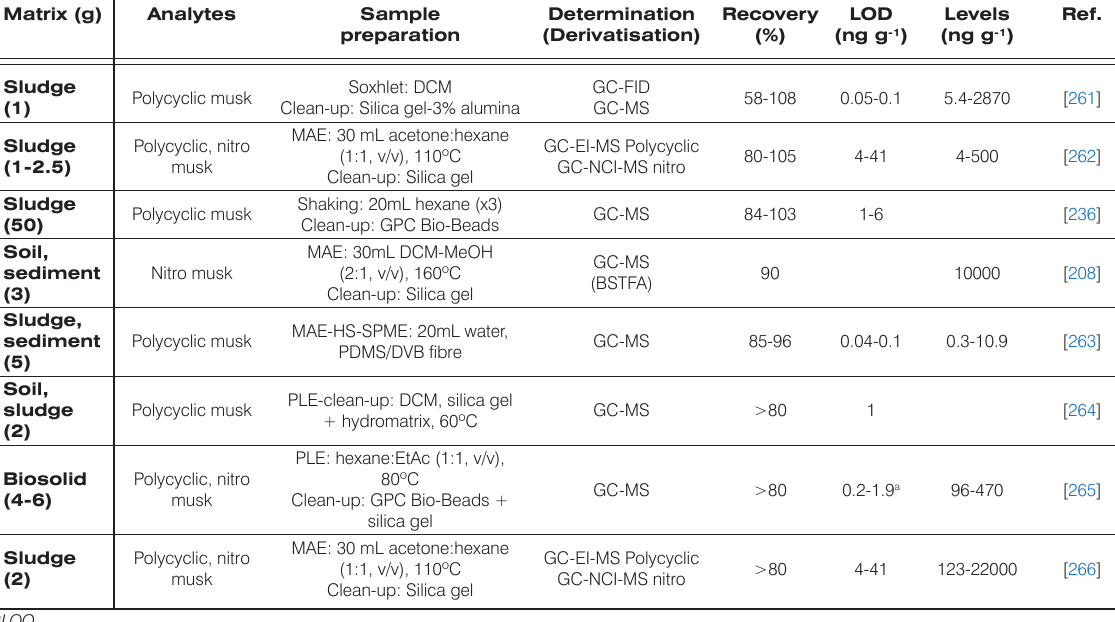
Table 12. Analysis of musk fragrances in environmental solid